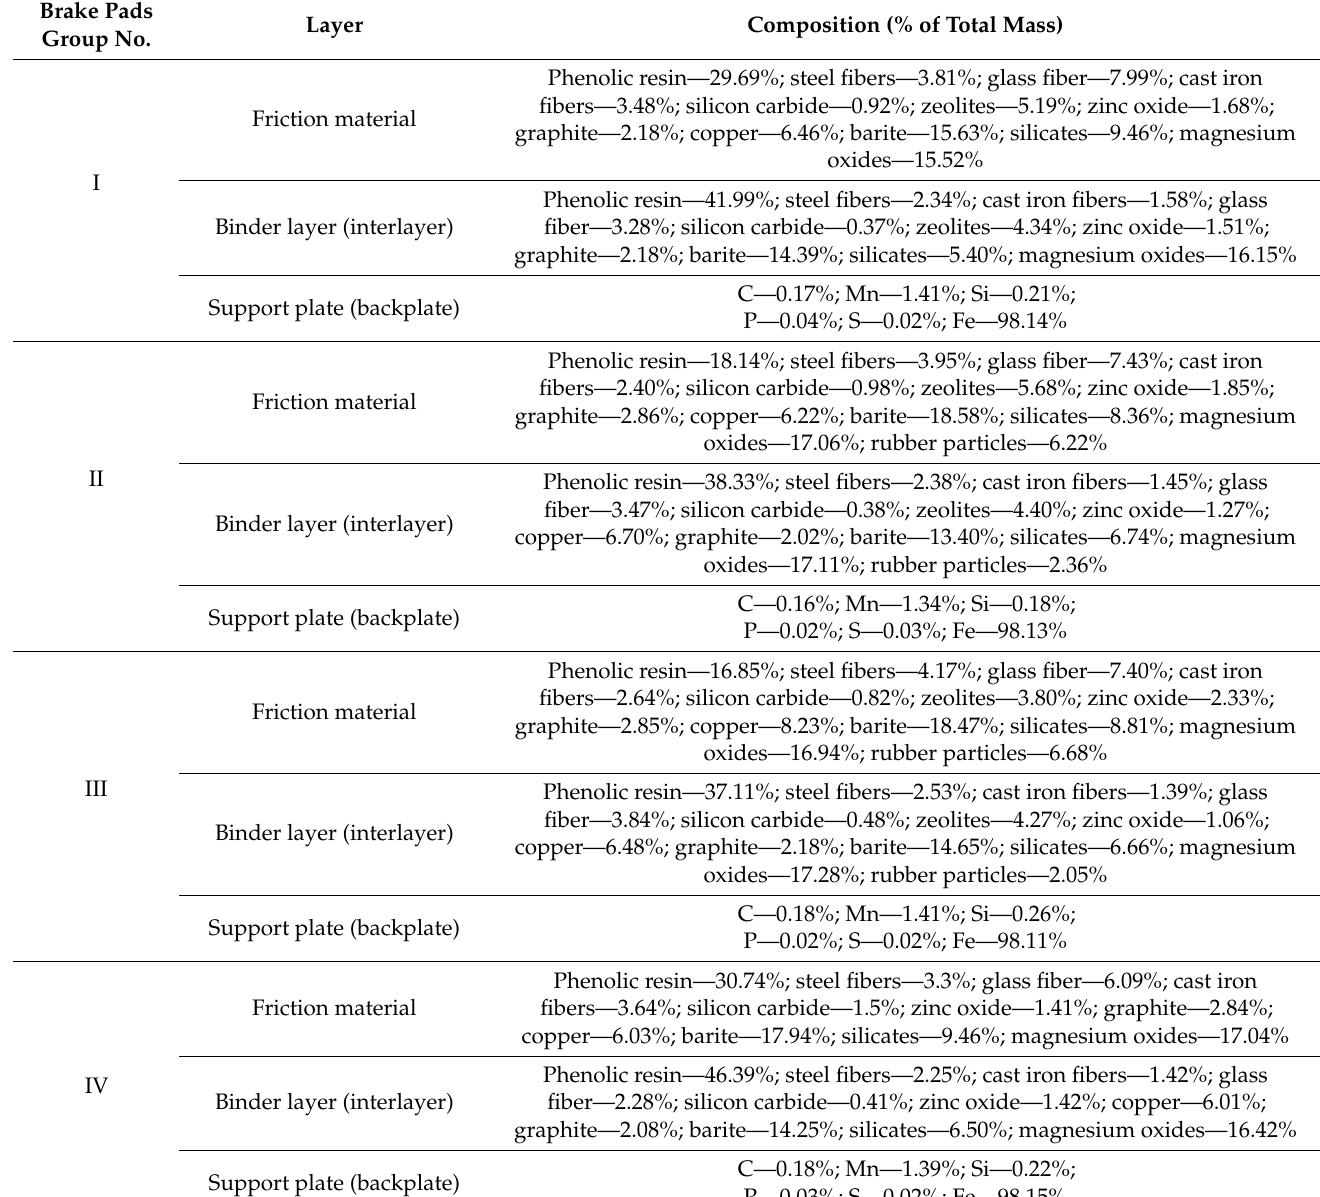
Table 2. Composition of individual samples and their